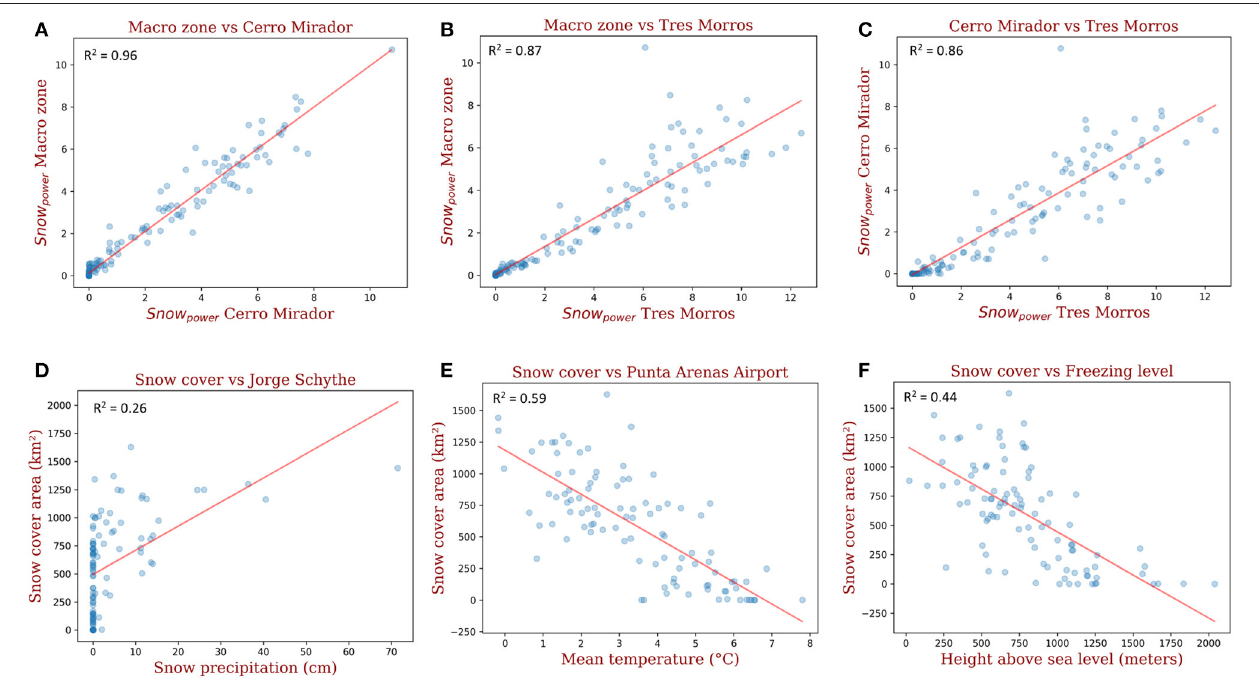
FIGURE 9 | Scatter plots. (A–C) show the correlation of the Snow power index between each study zones and the coefficient of determination ( R 2 ). (D–F) show the correlations of the MODIS reconstructed snow cover on the Macro zone between the most relevant climatic variables at a monthly level during the extended winter: snow precipitation at Jorge Schythe station, mean temperatute at Punta Arenas Airport, and freezing level at Punta Arenas Airport.